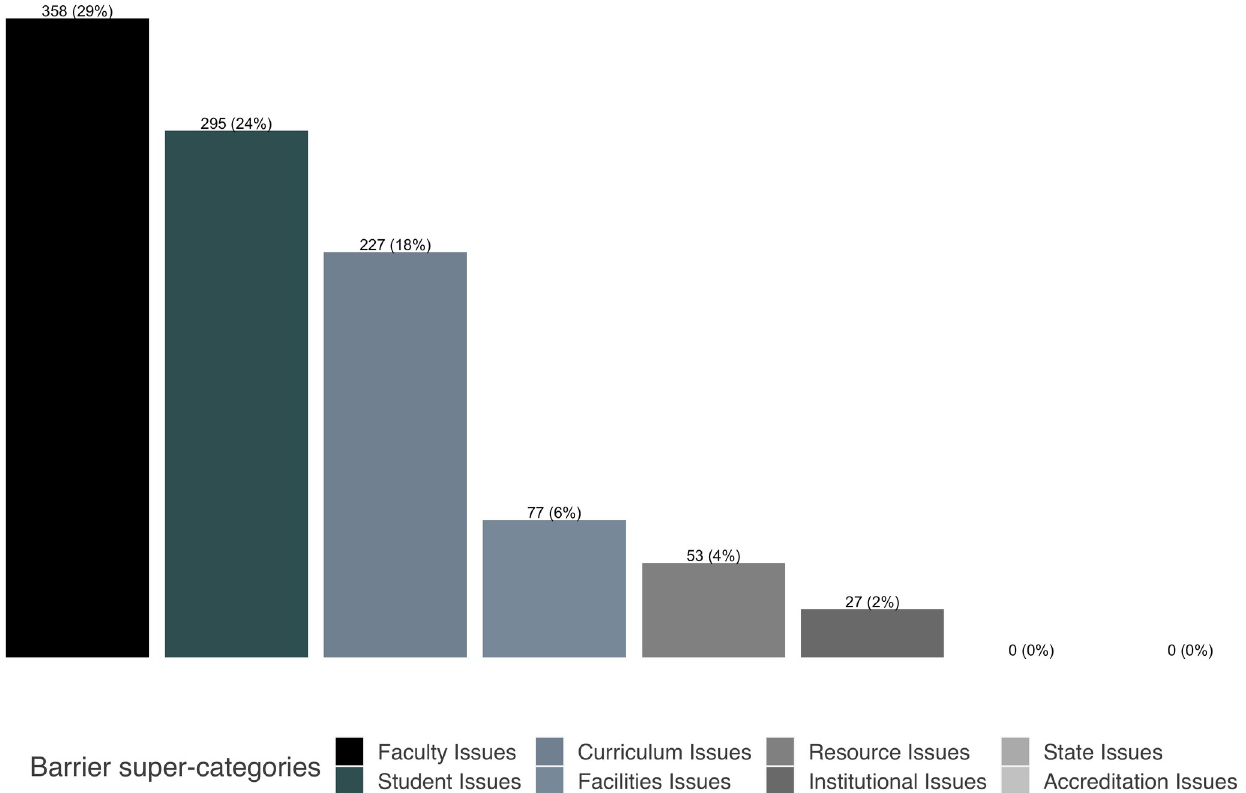
Fig 2. Summary of most commonly reported barriers by super-category. The number and percentage (in brackets) of respondents with comments corresponding to one of eight barrier super-categories are shown for Question 1. Seven hundred thirty-four respondents (of a total n = 1,231) provided a free-text response for this question. As shown, faculty-related barriers were the barriers reported most frequently.